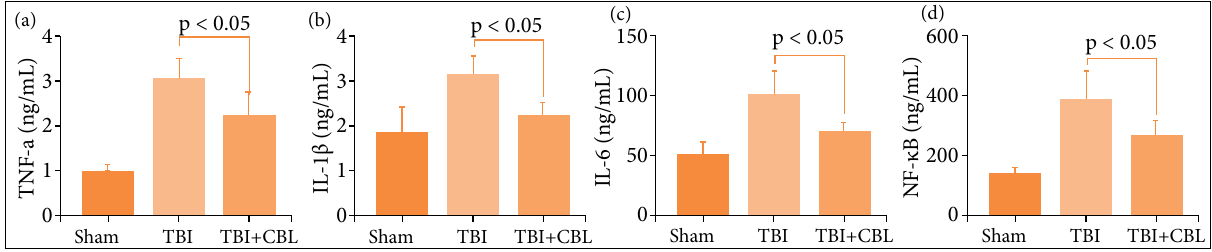
Figure 4 - CBL alleviates neuroinflammation after TBI. CBL significantly reduced hippocampal (a) TNF- α , (b) IL-1 β , (c) IL-6, and (d) NF- κ B levels at 72 h after TBI (n = 6, P < 0.05, analysis of variance; means ± standard error of mean).